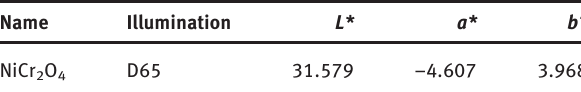
Table 1: Color ( L *. a *. b *) parameters of NiCr 2 O 4